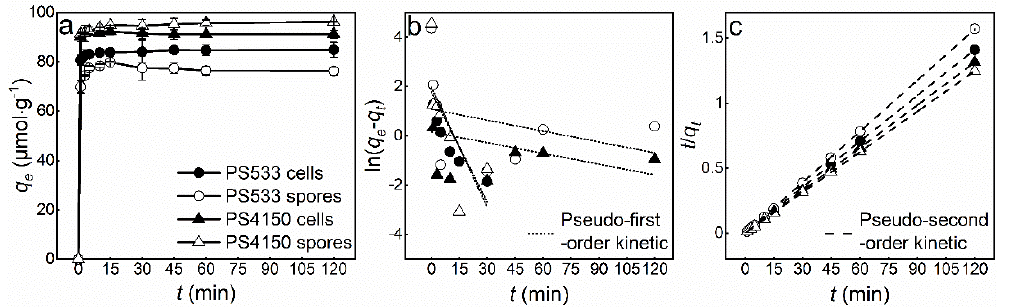
Figure 3. ( a ) The amount of Tb(III) adsorbed by B. subtilis PS533/PS4150 cells and spores were related to the contact time; ( b ) Pseudo − first − order kinetic model fitting; ( c ) Pseudo − second − order kinetic model fitting.